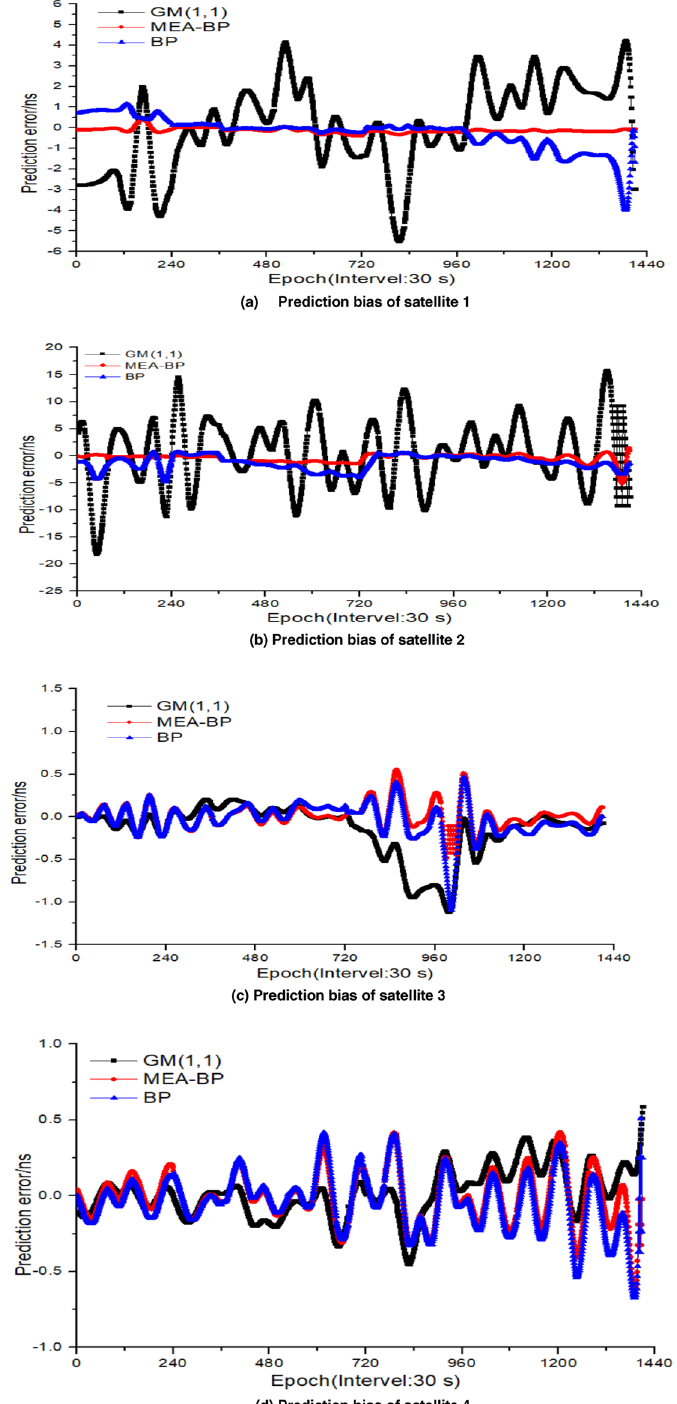
Figure 9. Comparison of the prediction bias of 12 h clock bias of the seven